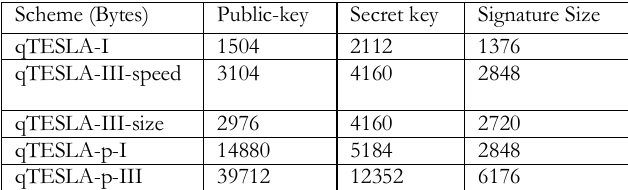
Table 10: qTESLA Public-Key, Secret key, and Signature Size Scheme (Bytes) Public-key Secret